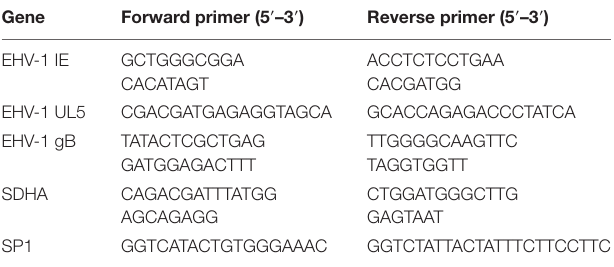
TaBle 1 | Primers used in SYBR quantitative RT-PCR